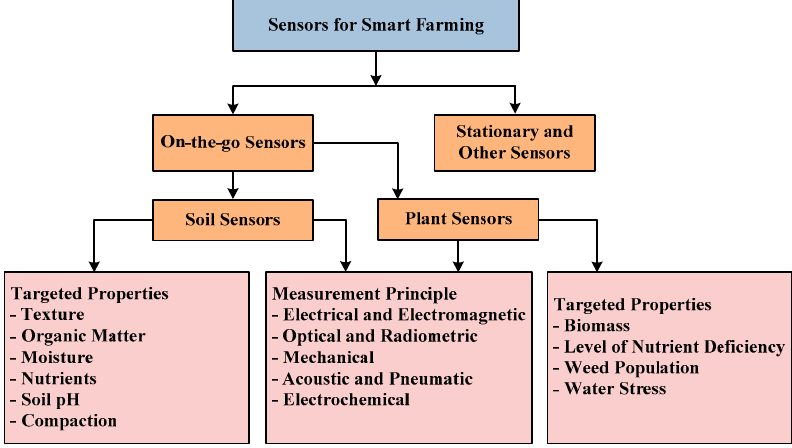
Figure 9. Soil and plant sensors used in smart framing.